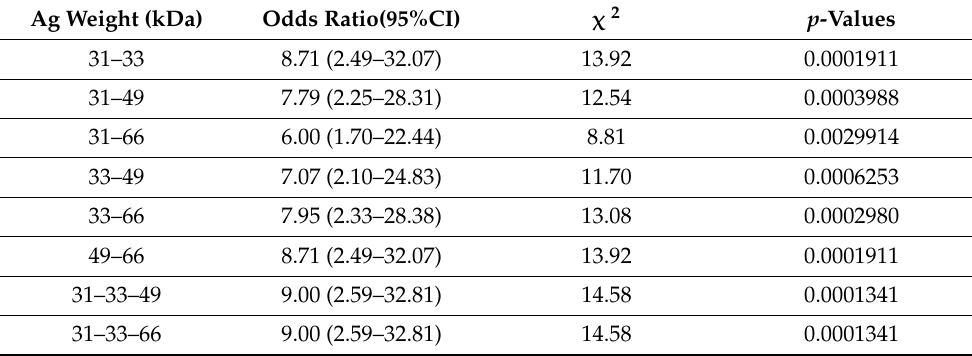
Table 3. Association levels expressed by OR (CI 95%) and Yates chi-square test between different combinations of immunodominant